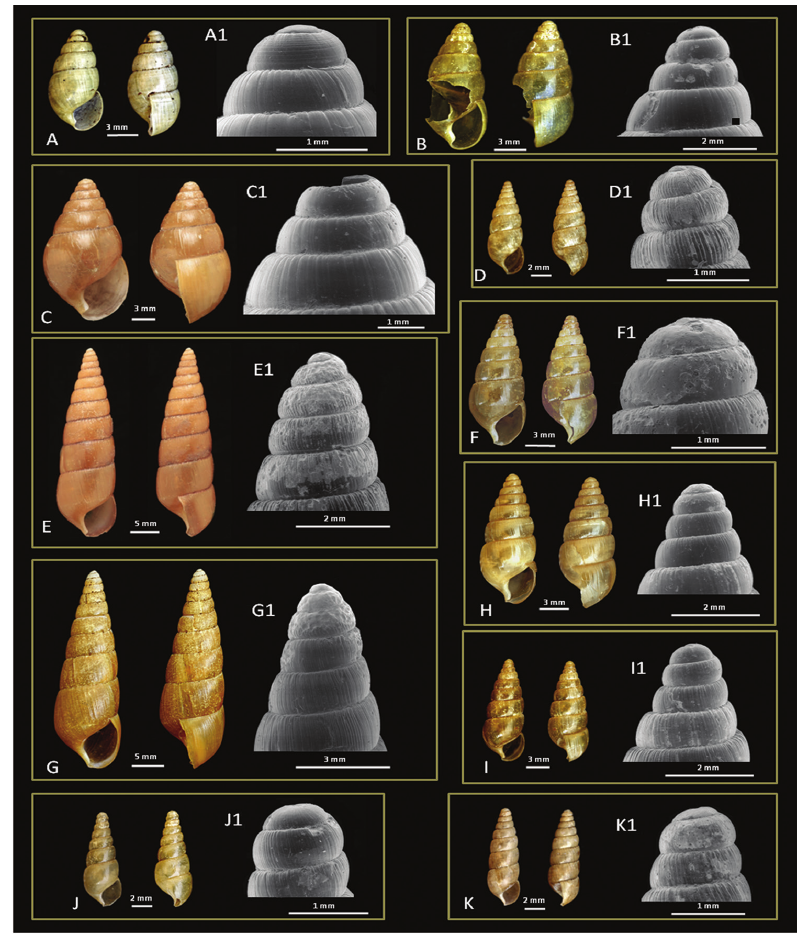
Figure 2. Shells ( A–K ) and SEM micrographs of apical whorls ( A1–K1 ) of Nepalese glessulines. A Gles- sula orobia (Benson, 1860): CDZMTU055P, shell of dissected specimen, Maipokhari, Ilam, Eastern Nepal B Glessula cf. hebetata : CDZMTU056P, shell of dissected specimen, Godawari, Lalitpur, Central Nepal C G. tamakoshi sp. n., holotype: CDZMTU057P, shell of dissected specimen, Suridobhan, left bank of Tamakoshi River, Dolakha District, Central Nepal D Rishetia hastula (Benson, 1860): CDZMTU059P, shell of dissected specimen, Chitwan National Park, riverine forest opposite bank of Sauraha, Rapti River E R. kathmandica sp. n., holotype: CDZMTU062P, shell of dissected specimen, Godawari Botanical Gar- den, Lalitpur, Central Nepal F R. cf. mastersi : CDZMTU065P, shell of dissected specimen, Kurintar, Chitwan, degraded riverine bushes with big boulders, mixed Shorea robusta forest G R. nagarjunensis sp. n., holotype: CDZMTU067P, shell of dissected specimen, Nagarjun forest, Balaju-Jamacho trail Nagarjun- Shivapuri National Park, Kathmandu, Nepal H R. rishikeshi sp. n., holotype: CDZMTU0170P, shell of dissected specimen, Jhawalepakho Community Forest, Ridi, Gulmi District, montane hill Shorea ro- busta forest I Rishetia sp. CDZMTU078P, shell of dissected specimen, Boshikharka, Dhading, Central Nepal J R. subulata sp.n., holotype: CDZMTU072P, shell of dissected specimen, Godawari, along the Godawari-Phulchowki road approx. 200 m above the Naudhara Temple K R. tribhuvana sp. n., holotype: CDZMTU077, shell of dissected specimen, Tribhuvan University garden, Kirtipur, Kathmandu,